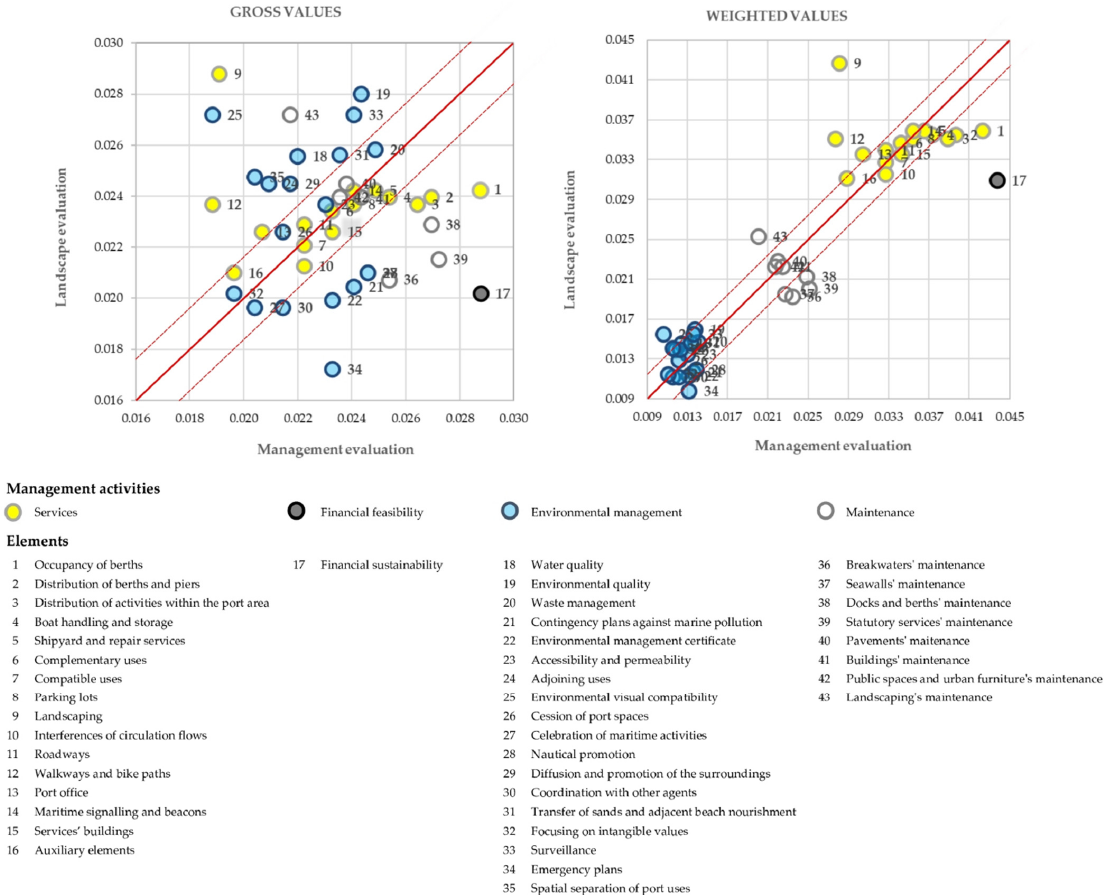
Figure 2. Rating framework, gross values.